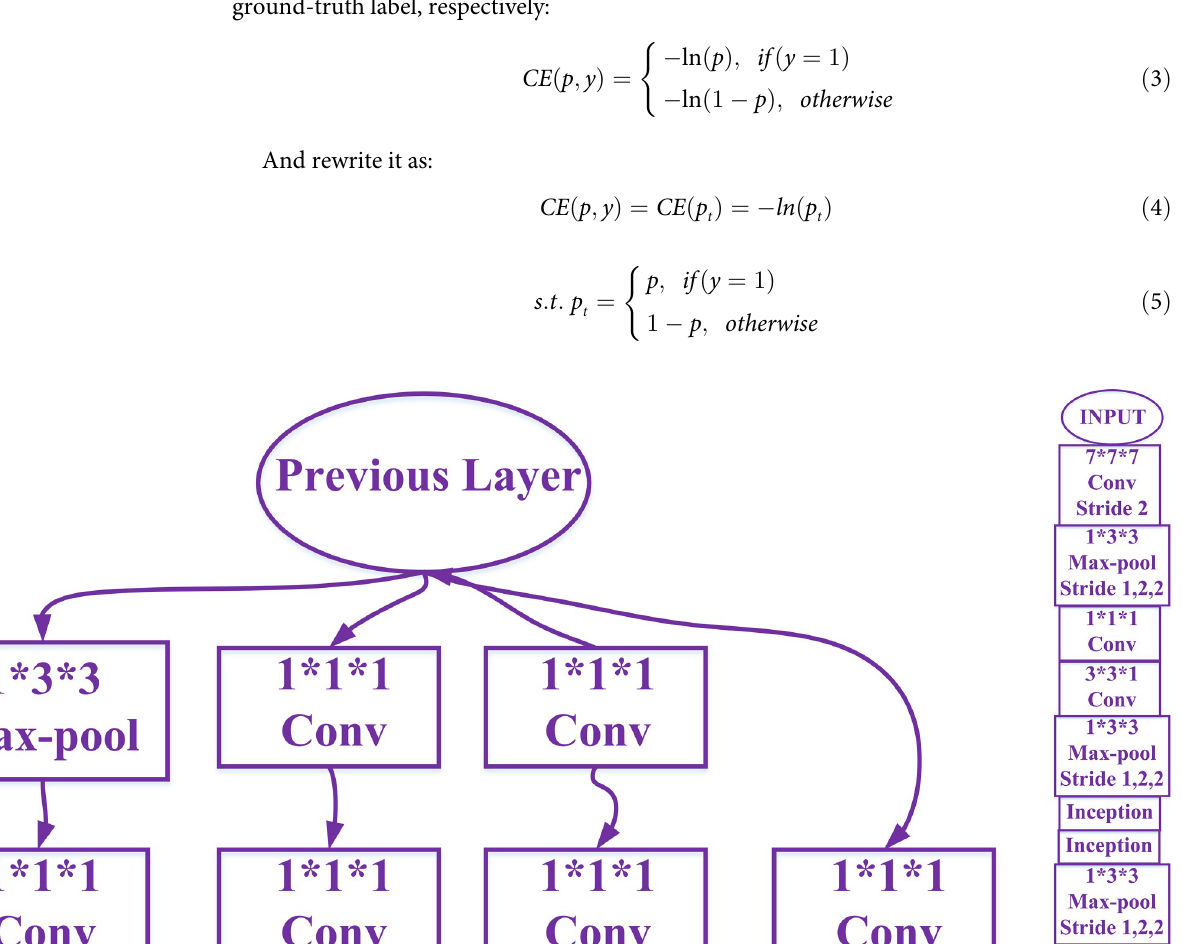
PLOS ONE | https://doi.org/10.1371/journal.pone.0266734 August 1,